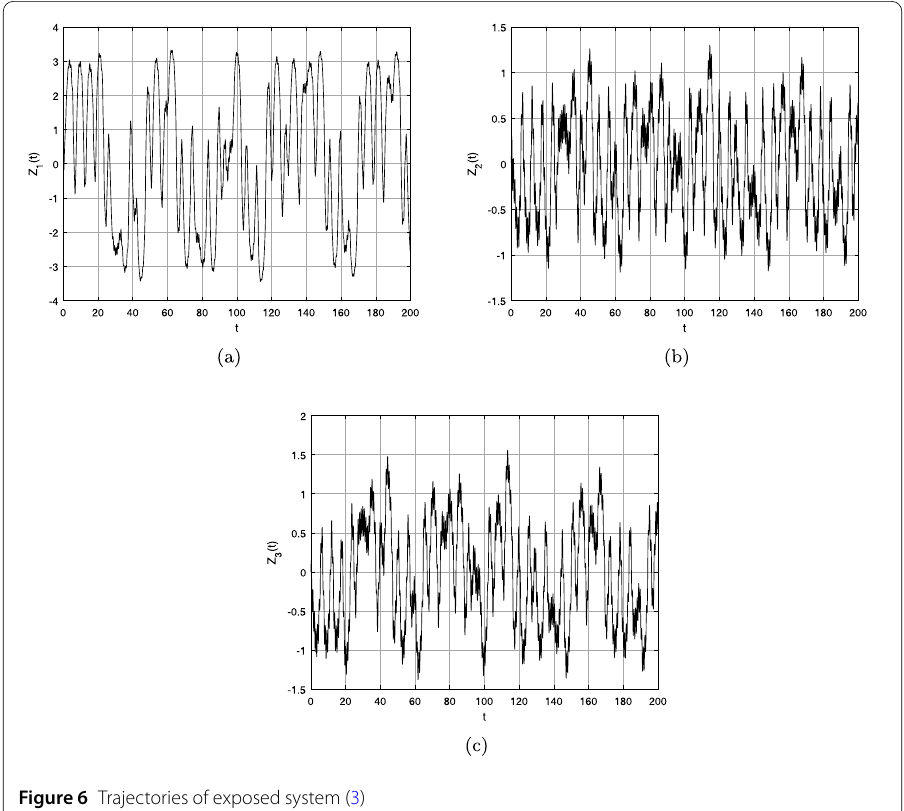
Figure 6 Trajectories of exposed system